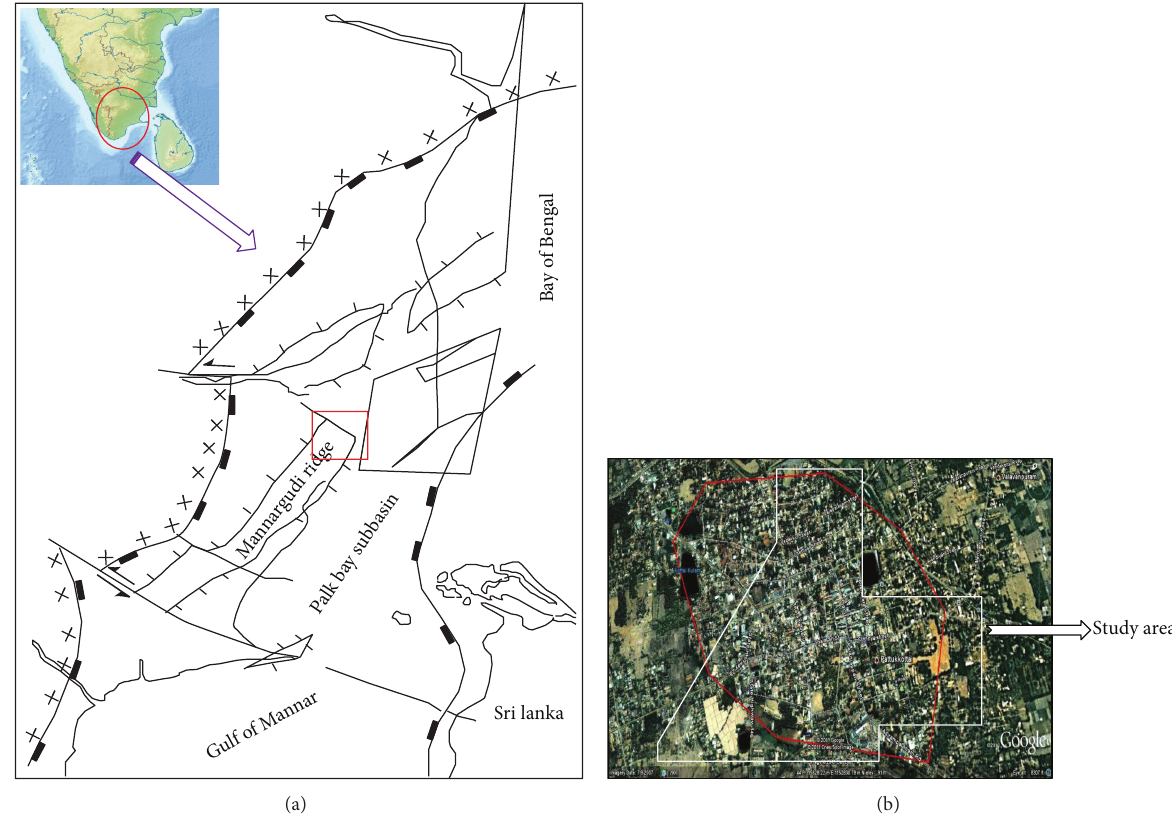
Figure 1: Location map. (a) Study area in blue polygon plotted on backdrop of tectonic map. (b) Study area in backdrop of demographic distribution.